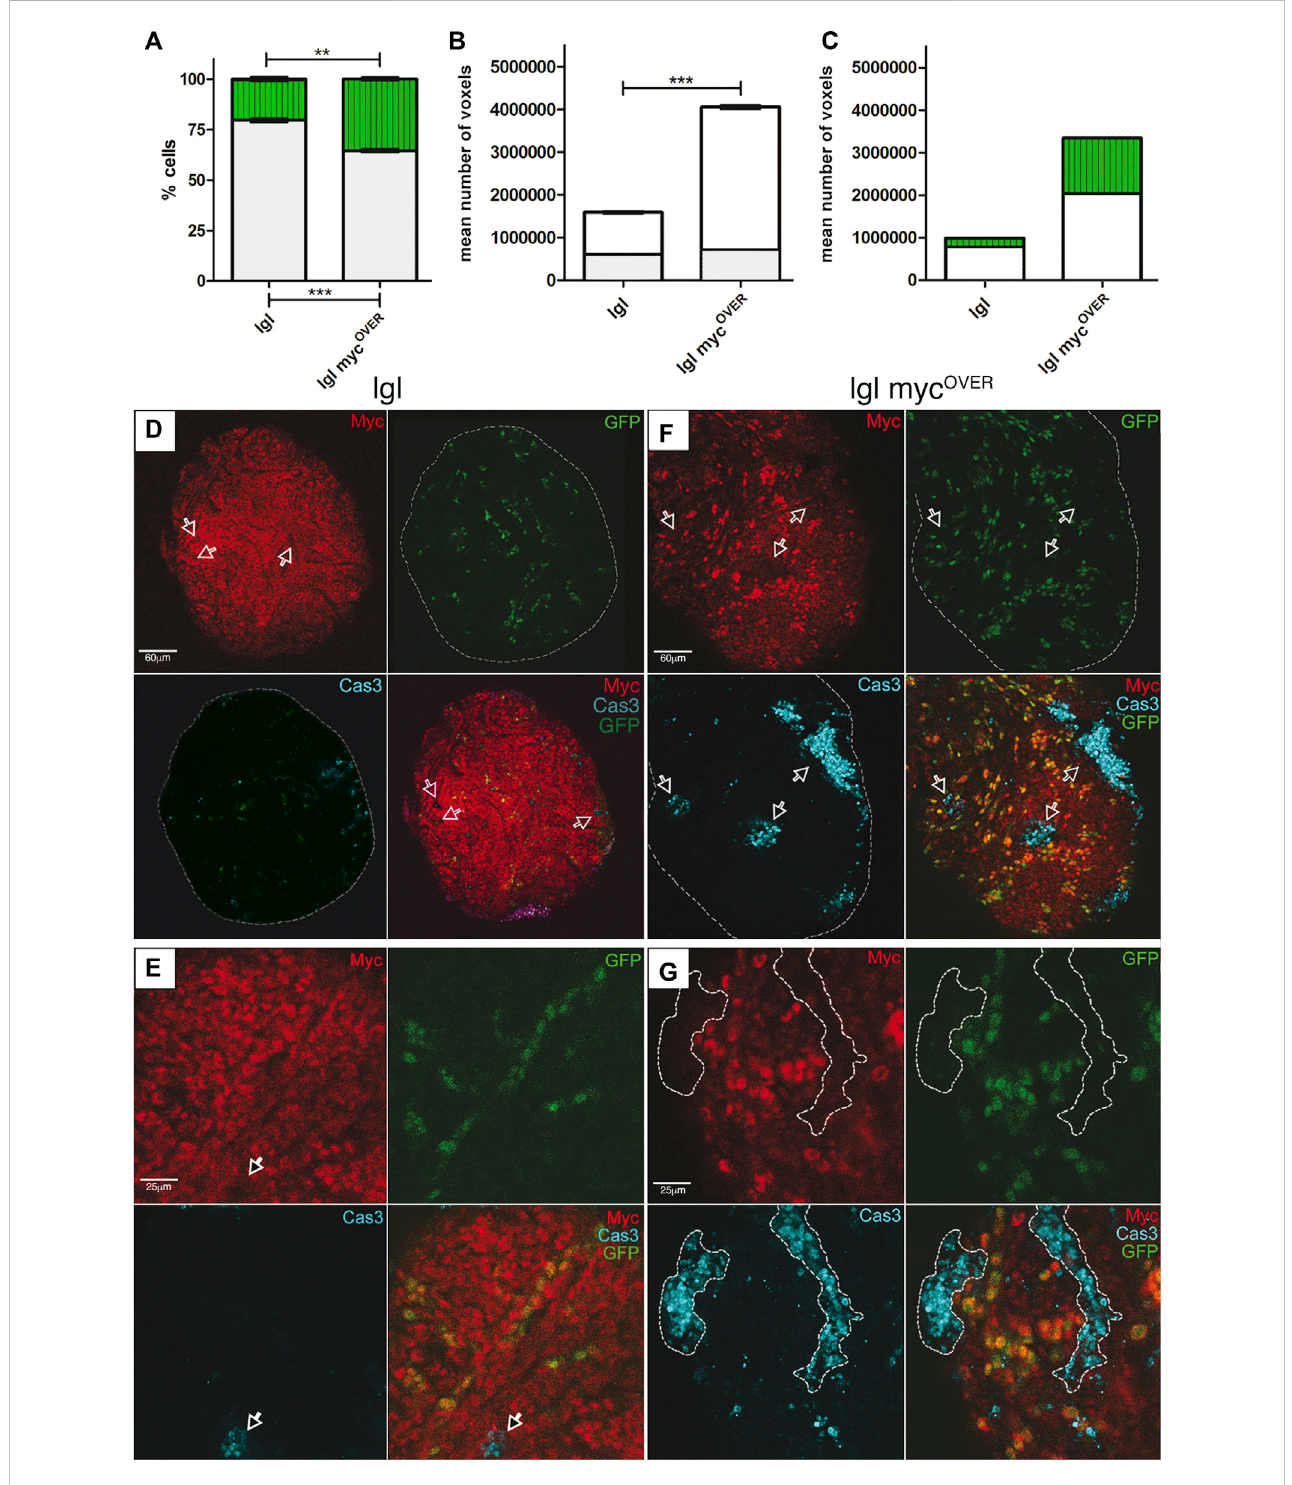
FIGURE 1 MYC-Mediated Cell Competition (MMCC) modi fi es tumor size and composition. (A) Percentage of GFP + (green) and GFP − (grey) cells in lgl tumors collected at 8 days AEL after inductionof neutral ( n = 68) and myc OVER ( n = 59) clones at 6 days AEL. See SupplementaryTable 1 for plain genotypes. (B) Mean volumeofthesamesamplesasinAcalculatedfromtheimagesacquiredimmediatelybeforedissociation(8 daysAEL).Thegreypartofthebarsrepresentsthe pre-induction volume (6 days AEL, n = 55 for neutral and n = 51 for myc OVER samples). (C) Relative volumes of GFP + (green) and GFP − (white) cells in neutral and myc OVER samples after clone induction, calculated as described in the Methods section. Statistical signi fi cance and ±SEM are indicated. (D,E) MYC (red) and activated Cas3 (cyan) staining of lgl tumors collected at 8 days AEL in which GFP + , neutral clones were induced at 6 days AEL. The arrows highlight cells downregulating MYC positive to Cas3 signal. (F,G) MYC (red) and activated Cas3 (cyan) staining of lgl tumors collected at 8 days AEL in which GFP + , myc OVER cloneswereinducedat6 daysAEL.Thearrowsin (F) andthedottedlinesin (G) highlightcellswithendogenous levelsofMYC,positive toCas3signal. All the images represent disc cross-sections. Scale bars are indicated for each